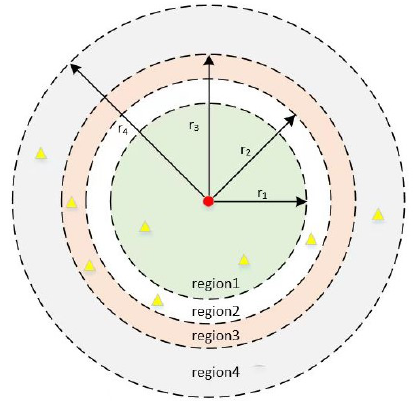
Figure 3. Schematic of shooting reward. We take the target point as the center of the circle, and according to the SDR evaluation index of the data, we divide four regions with the radii of 2.0 mm, 2.5 mm, 3.0 mm, and 4.0 mm. The red points represent the ground truth, and the yellow points represent the landmarks predicted by the model. The predicted landmarks fall into different regions to give them different